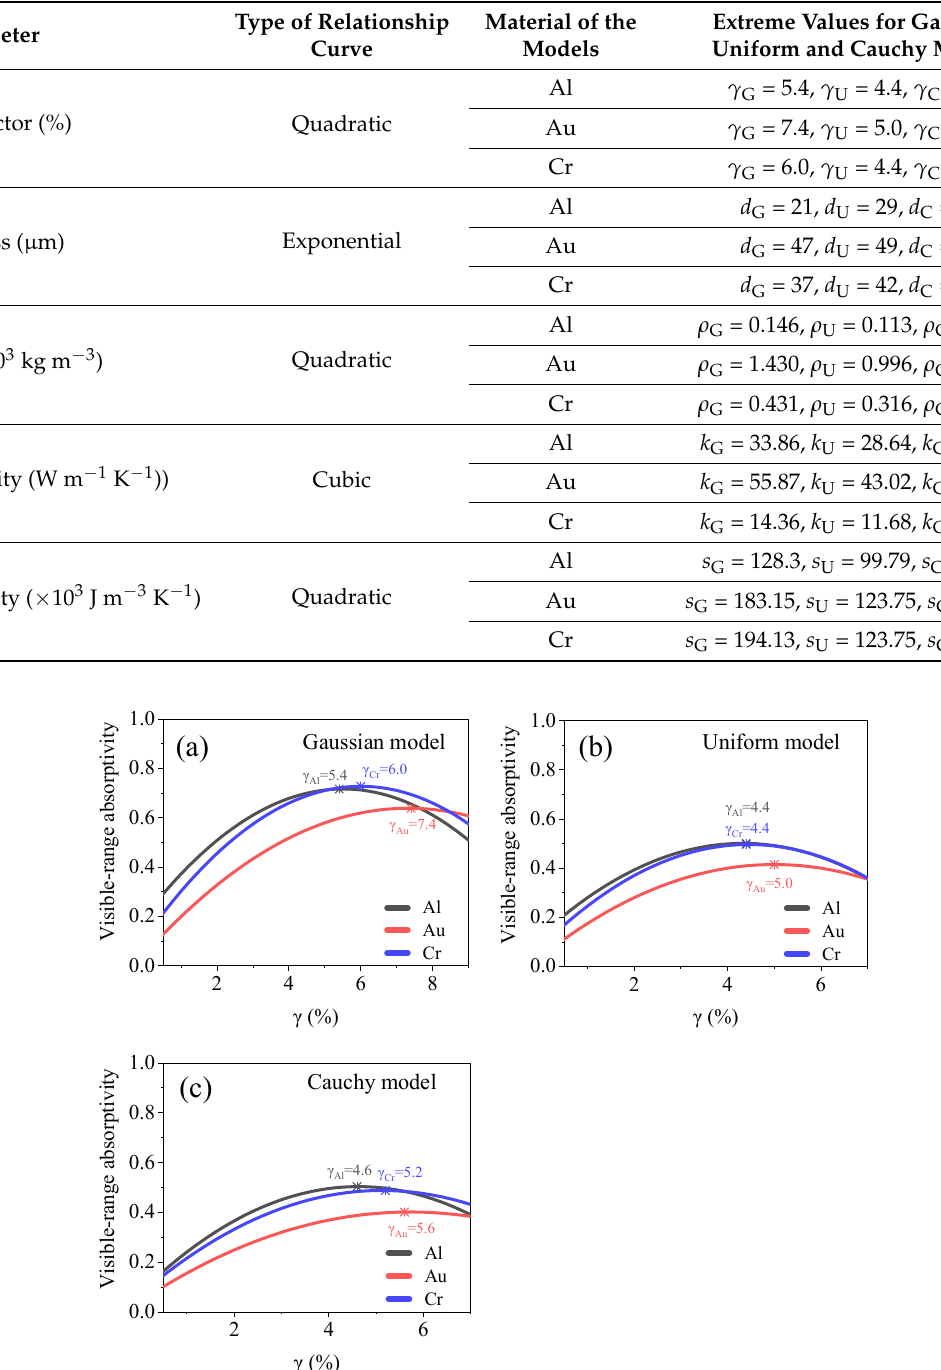
Table 1. Relationships between model parameters and visible-range absorptivity.